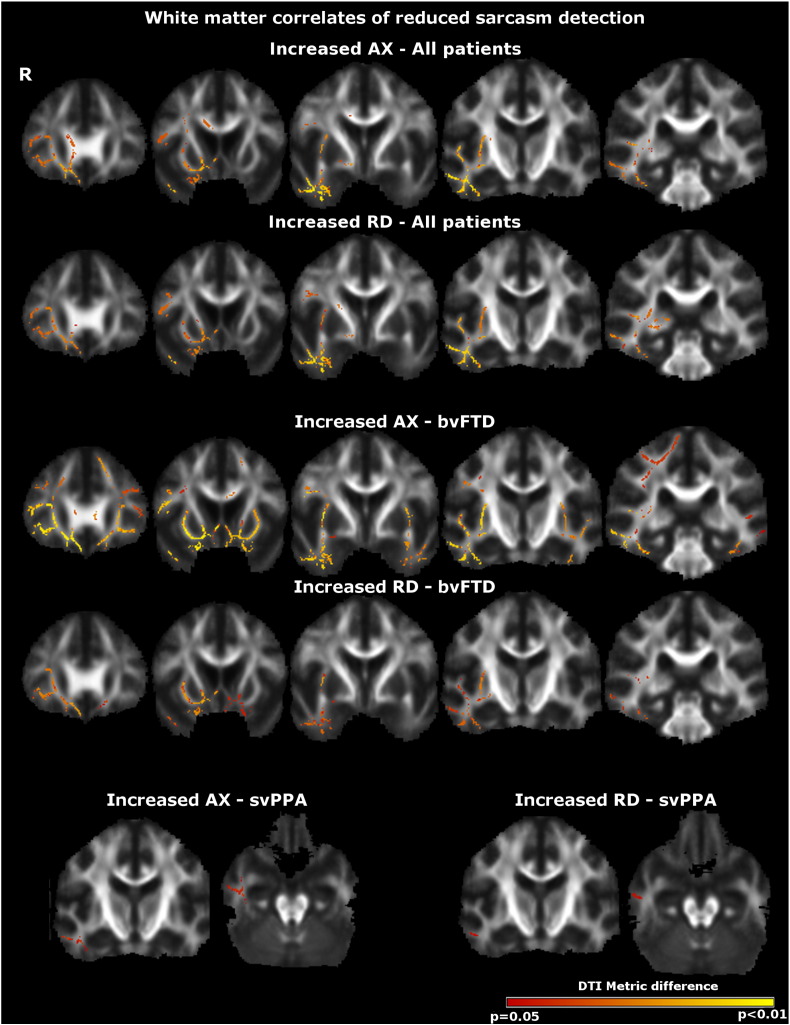
White matter tract correlates of reduced sarcasm identification across both patient groups (top panels), in the bvFTD group alone (middle panels) and in the svPPA group alone (bottom panels). Results are overlaid on a customised group template brain image and displayed in MNI standard space; the right hemisphere (R) is displayed on the left. The colour scale indexes p-value after family-wise error correction over the whole brain at p < 0.05. Key: AX, axial diffusivity; bvFTD, behavioural variant frontotemporal dementia; RD, radial diffusivity, svPPA, semantic variant of primary progressive aphasia.